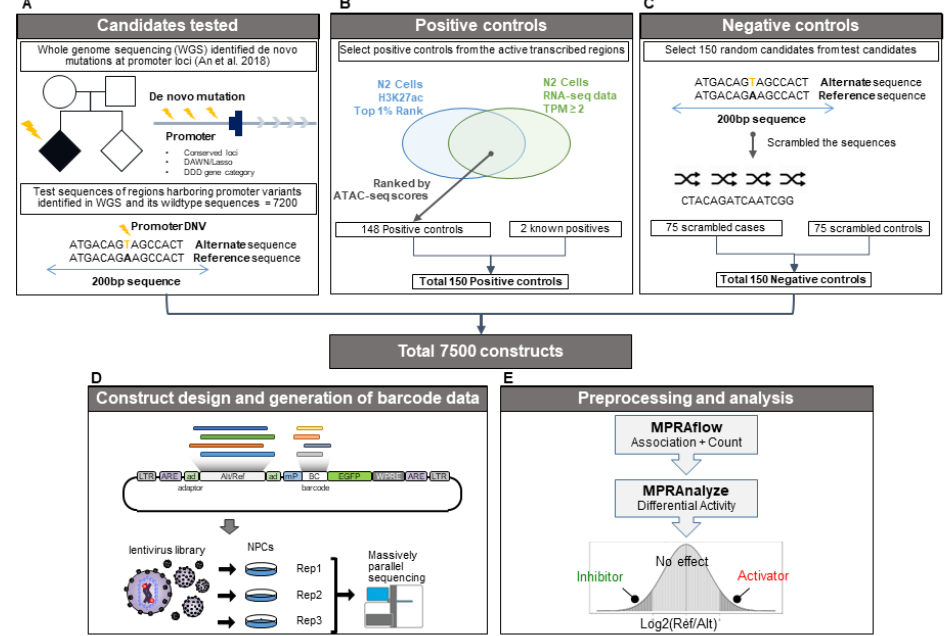
Figure 1. LentiMPRA analysis pipeline. ( A ) Selection of the 7200 candidate regulatory sequences (CRS) generated from the reference and alternate allele sequences of 3600 variants. ( B ) Selection process of the top active regions in N2 cells used to generate the positive control sequences. ( C ) Se- lection process for generating the negative control sequences. ( D ) Diagram of the lentiviral vector used for infection into our three replicate NPC cell populations. ( E ) Diagram of the computational pipeline used to associate and count the randomly added CRS and barcode sequences to be used for differential expression analysis